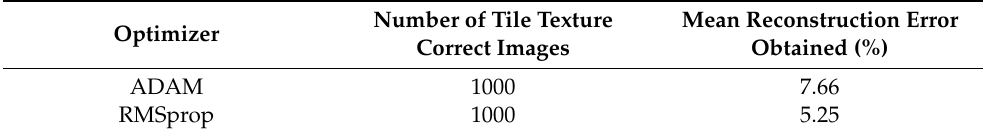
Table 1. Reconstruction error obtained for both optimizers.